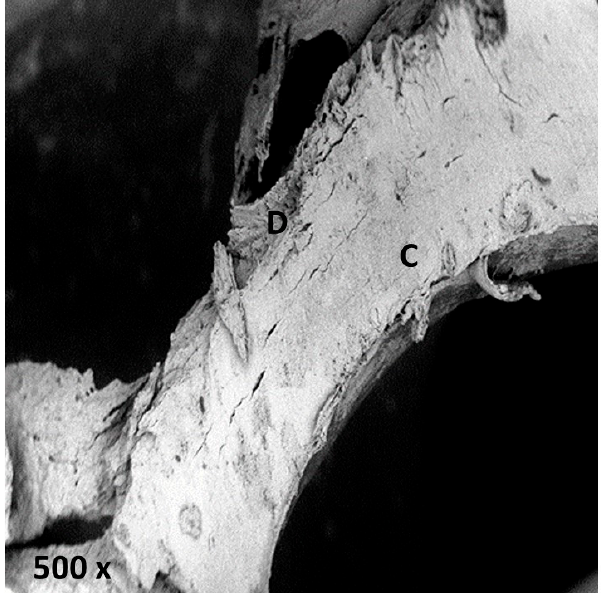
Figure 5. Sonosurgery SFS 101 tip sample surface (D—debris, C—carbonization).